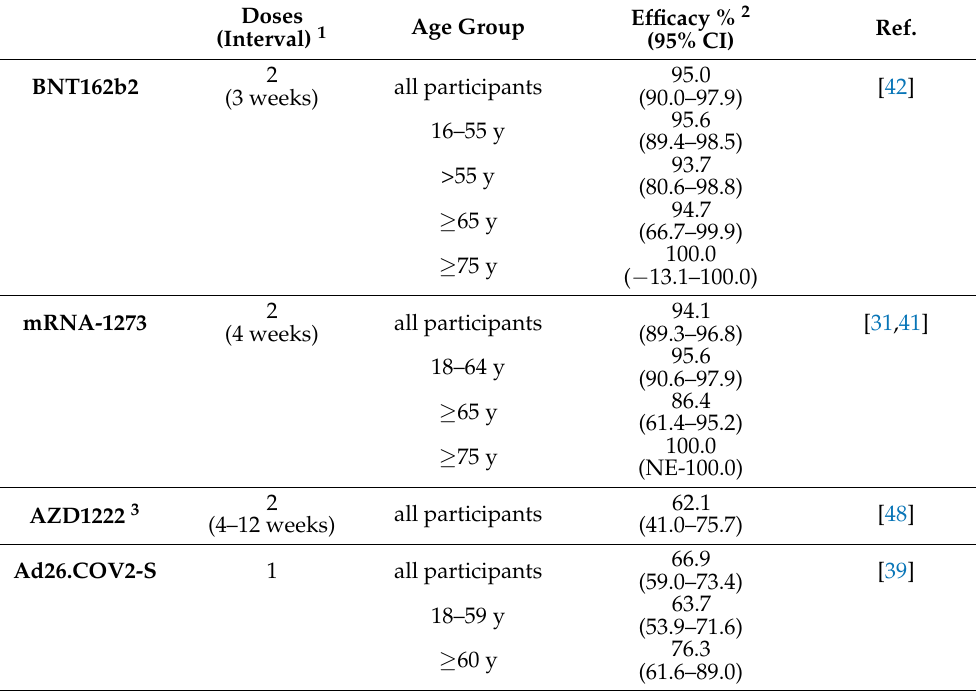
Table 2. Dose intervals and vaccine efficacy of BNT162b2, mRNA-1273, AZD1222, and Ad26.COV2-S in the pivotal Phase III clinical